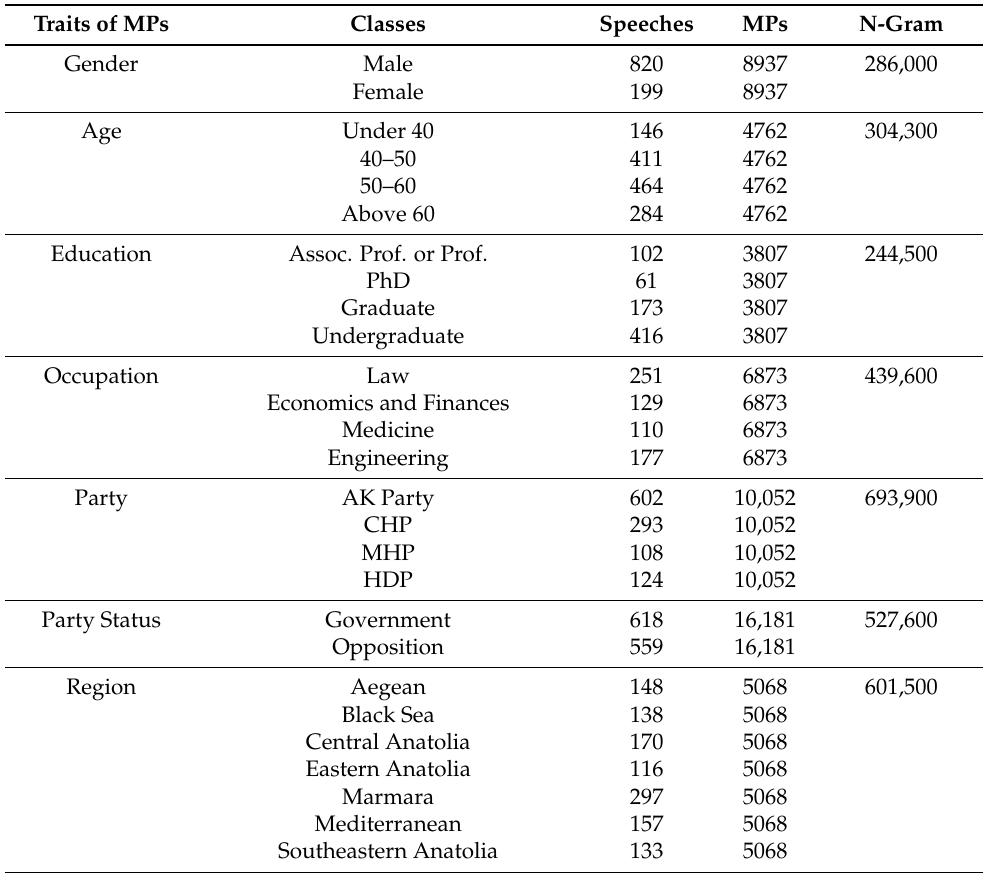
Table 2. Datasets for estimation of demographic traits. Traits of